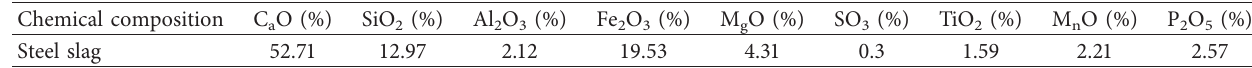
Table 1: Chemical composition of the steel slag